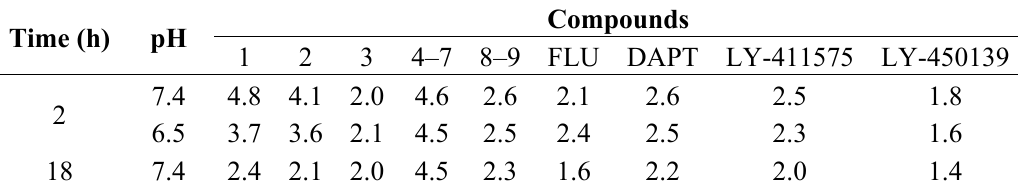
of compounds 1 – 9 IAM/W